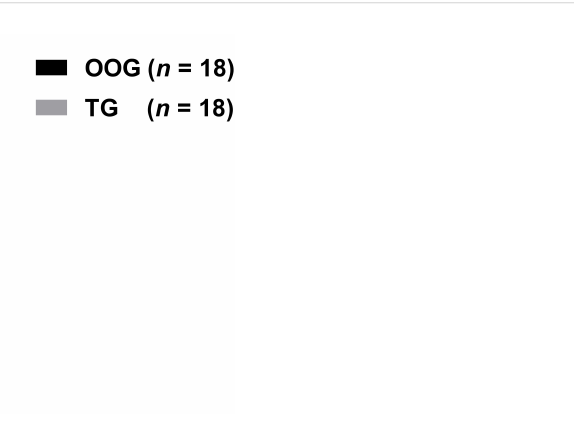
FIGURE 1 Comparison of the time of onset of puberty between OOG and